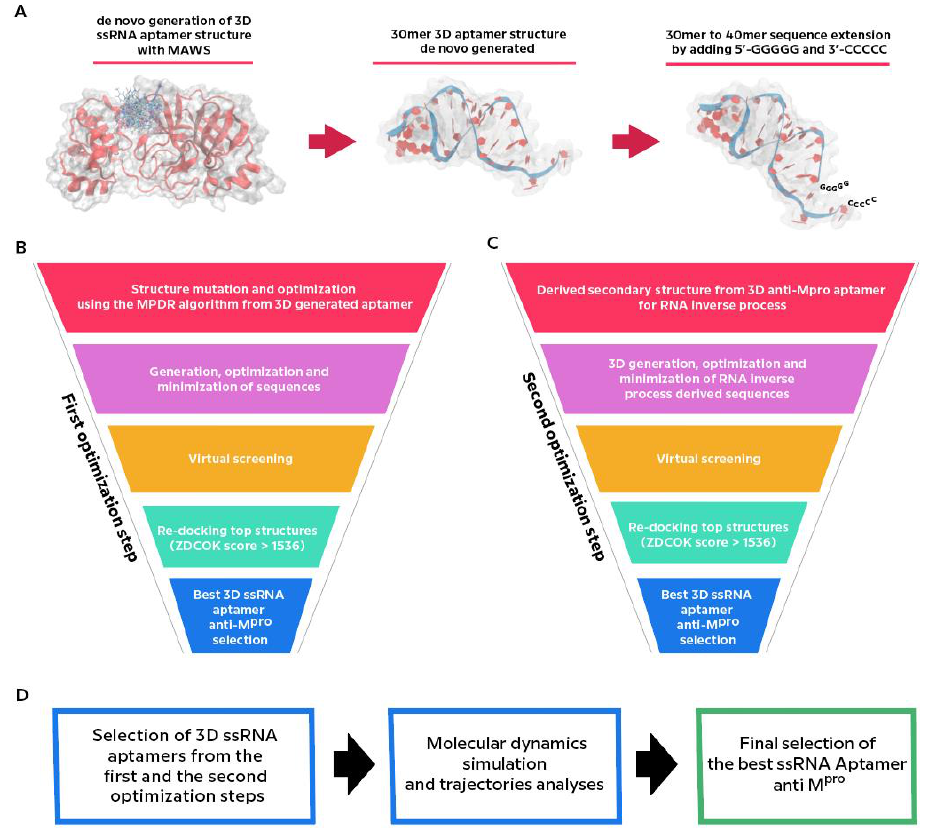
Figure 1. Schematic of the workflow for the anti-M pro ssRNA aptamers. ( A ) initial 30mer 3D aptamer generation. ( B ) First optimization step. ( C ) Second optimization step. ( D ) Schematic of Molecular Dynamics simulation and trajectories analyses and best aptamer selection. See the details in the text.